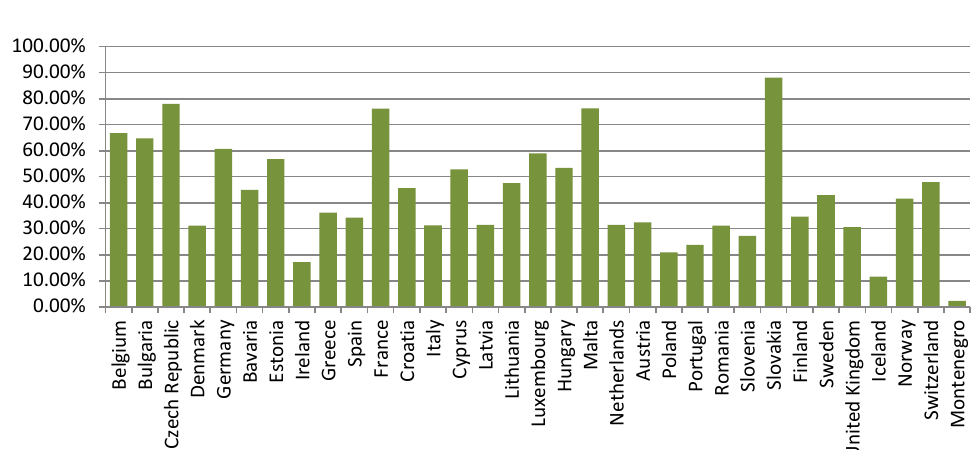
Fig. 1. Percentage of leased agricultural land of total agricultural land area in 2010. (Eurostat 2015). Based on number of farms and areas by agricultural size of farm ( UAA). 11